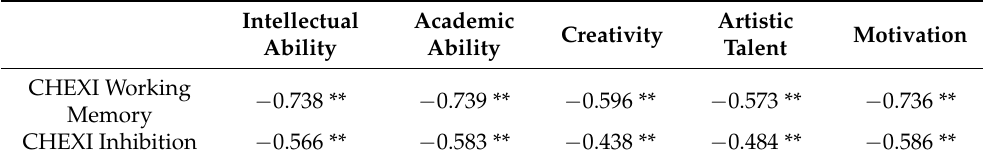
Table 3. Correlations between GRS-Ps and working memory and inhibition subscales of Childhood Executive Functioning Inventory (CHEXI). Artistic Intellectual Academic Motivation Creativity Talent Ability Ability CHEXI Working − 0.738 ** − 0.739 Memory